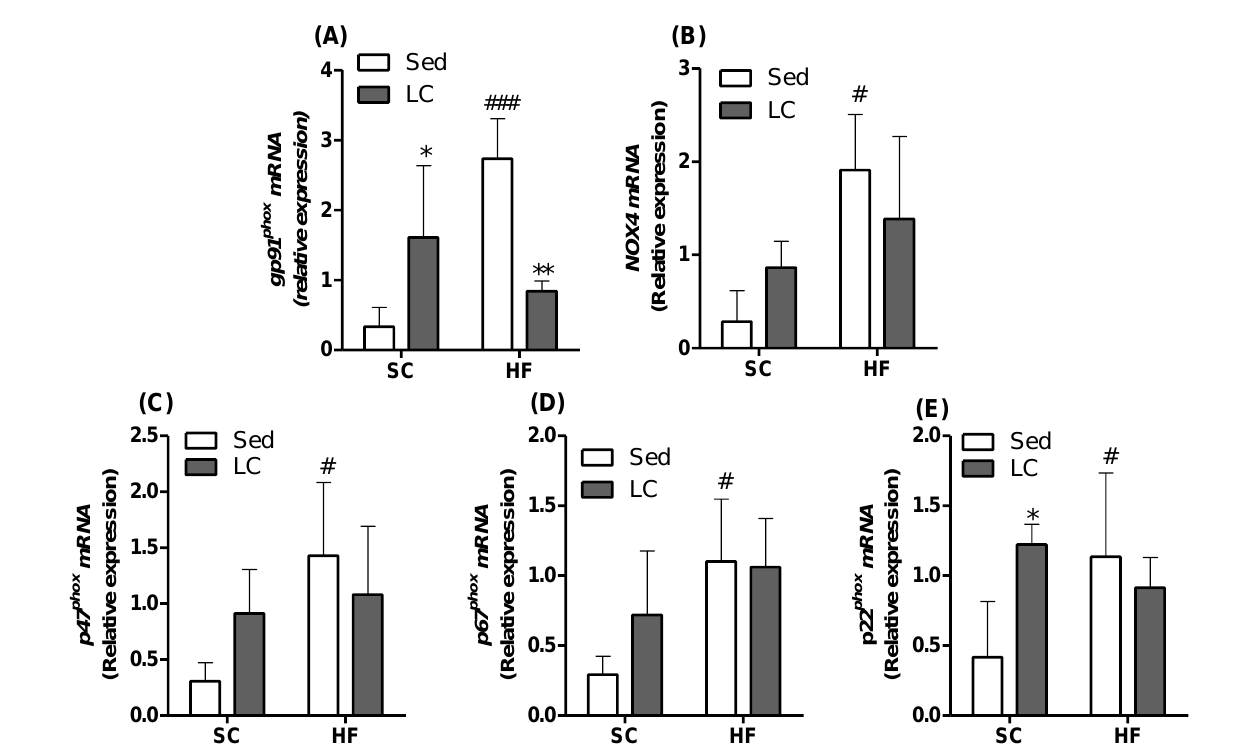
Figure 7. The effects of 8 weeks of LC on the gene expression of NADPH subunits in the gastrocnemius muscles of mice fed either SC or HF diet. ( A ) gp91 phox membrane subunit; ( B ) NOX4 membrane subunit; ( C ) p47 phox cytosolic subunit; ( D ) p67 phox cytosolic subunit; ( E ) p22 phox membrane/cytosolic subunit. Data presented as relative mRNA expression. Two-way ANOVA with Bonferroni posthoc test ( n = 4). * p < 0.05, ** p < 0.01 vs. respective sedentary (Sed) group; # p < 0.05; ### p < 0.001 vs. respective standard chow (SC)